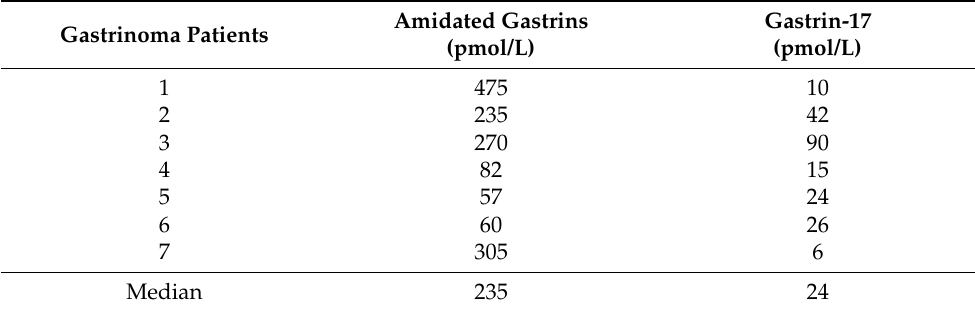
Table 2. Plasma concentrations of amidated gastrins versus gastrin-17 in consecutive gastrinoma